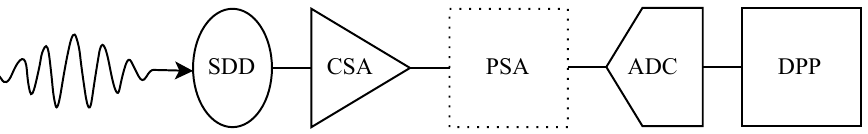
Figure 1. Block diagram of a typical single-photon detection system showing the incident photon on the silicon drift detector (SDD), charge-sensitive amplifier (CSA), optional pulse-shaping amplifier (PSA), analog-to-digital converter (ADC), and digital pulse processor